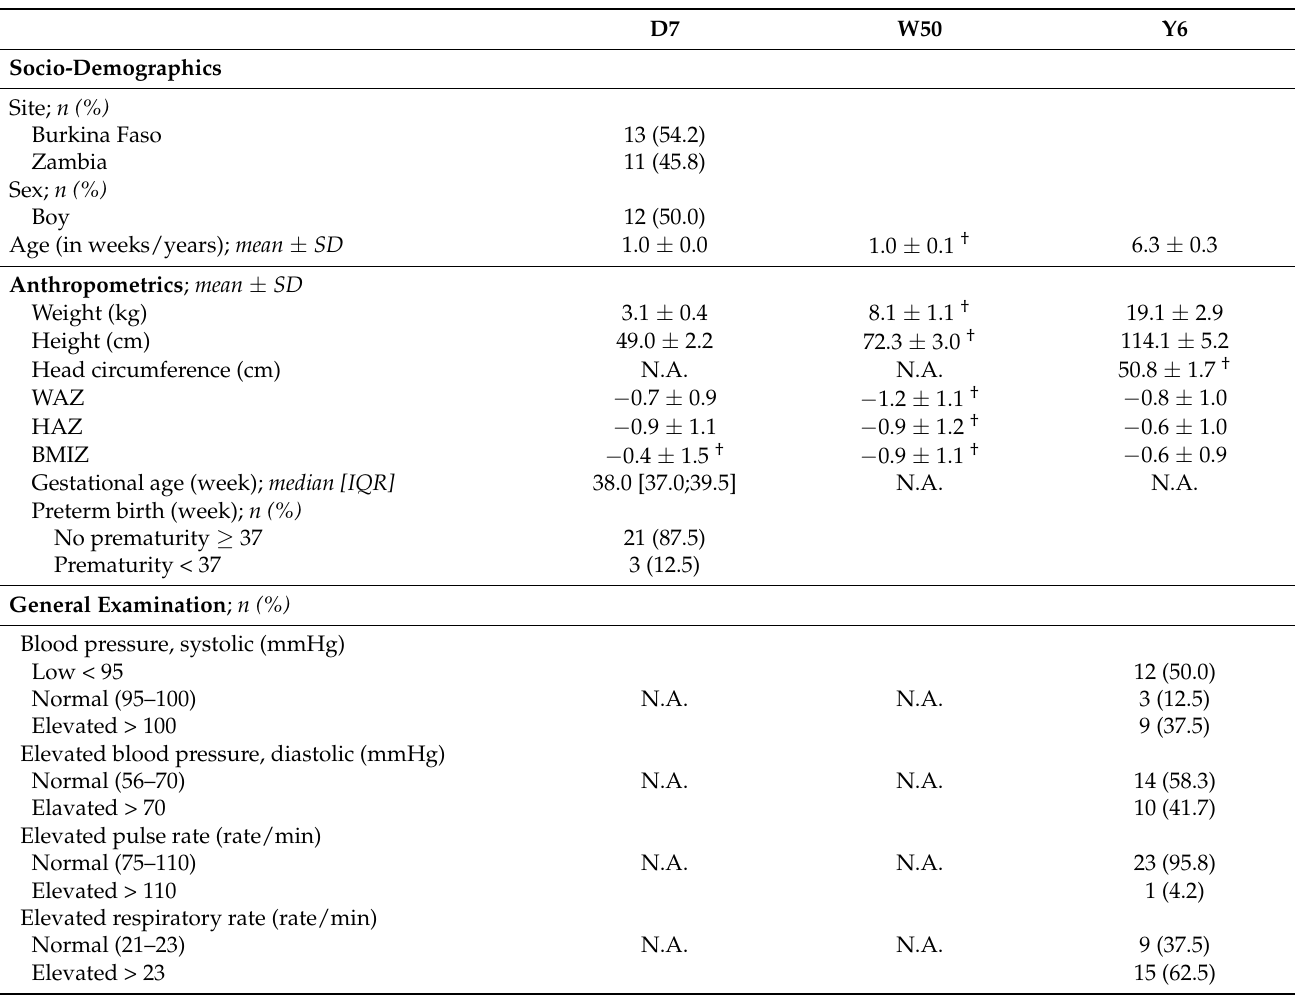
Table 1. Characteristics of HEU at the three time points. D7 W50